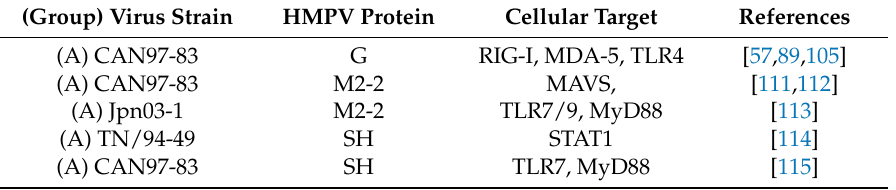
Figure 3. Inhibition of interferon response by HMPV. Evasion mechanisms used by HMPV include: impairment of RIG-I and MDA5 signaling by its G protein; attenuation of MAV or MyD88 signaling by its M2-2 protein; and obstruction of TLR7/MyD88 signaling by its SH protein. Table 2. HMPV proteins that target cellular molecules to inhibit IFN